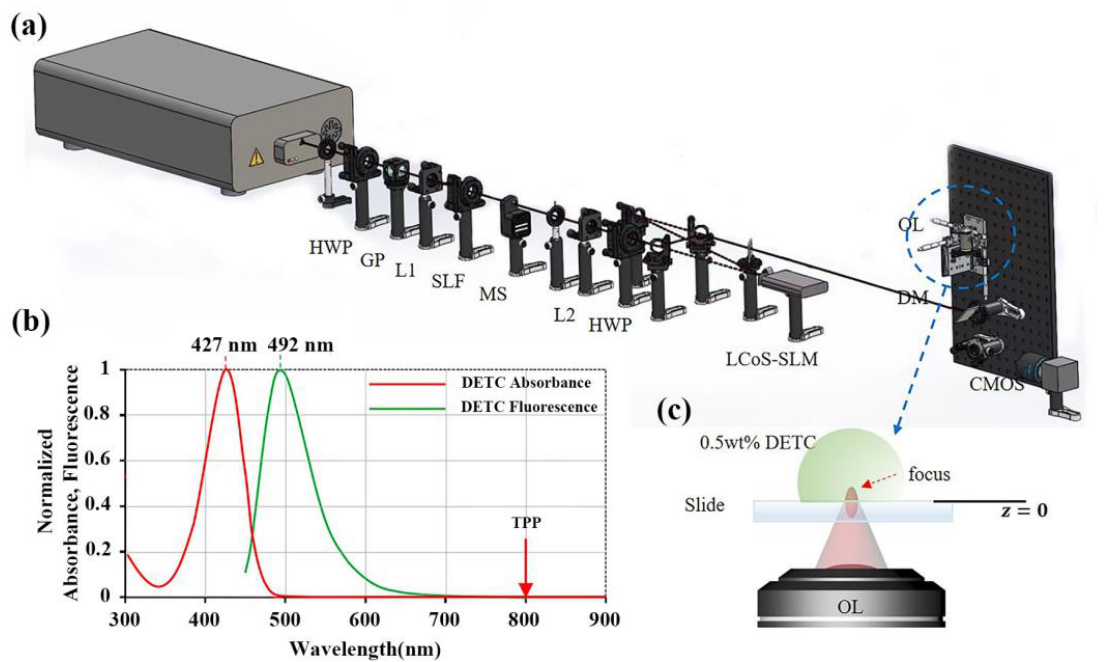
Figure 5. Experimental fabrication with SVG-guided SLM LDW. ( a ) Diagram of the experiment setup. HWP: half-wave plate, GP: Glan prism, SLF: spatial light filter, lenses: L1 and L2 composing a beam expander, MS: mechanical shutter, LCoS: liquid crystal plate on silicon SLM, DM: dichroic mirror, OL: objective lens, R: reflector, and CMOS: CMOS camera. ( b ) Absorbance and fluorescence spectra of 0.5 wt% 7-diethylamino3-thenoylcoumarin (DETC) [50] . ( c ) Schematic of TPP laser writing. 𝑧 = 0 refers to the modulated laser is located at the interface of the photoresist and slide.